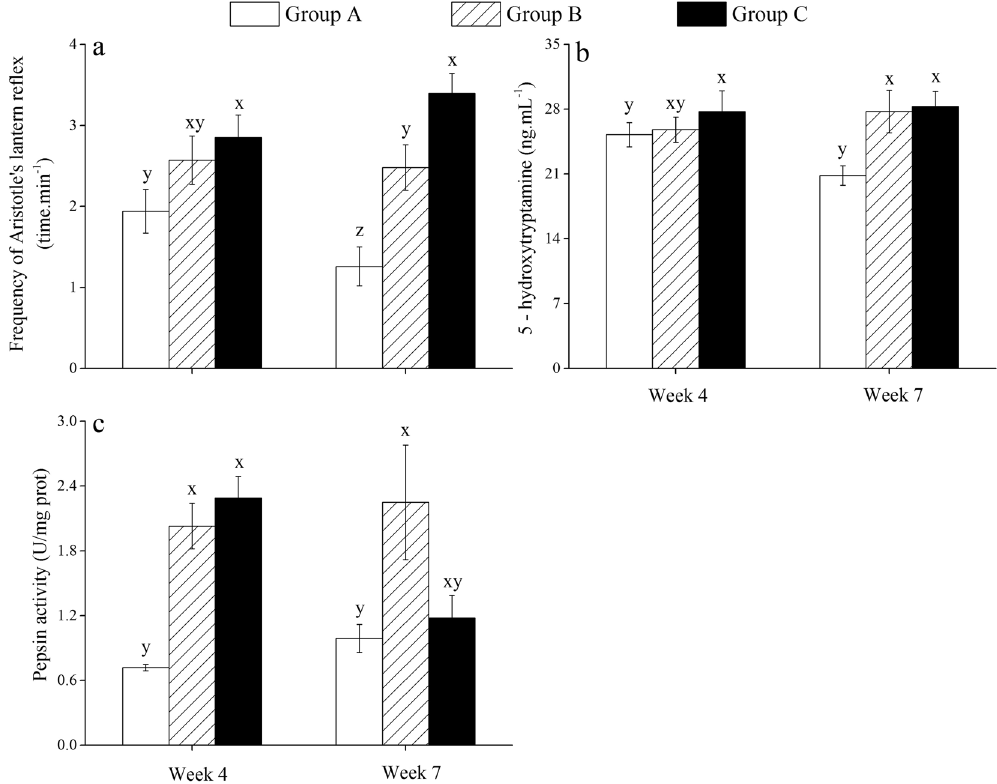
Figure 5. Aristotle’s lantern reflex ( a ), the concentration of 5-hydroxytryptamine ( b ) and pepsin activity ( c ) of Strongylocentrotus intermedius of the experimental groups in week 4 and week 7 (mean ± SD, N = 8). Letters above the bars represent significance in each week ( P < 0.05).